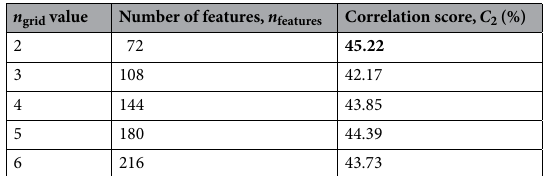
n features Correlation score,